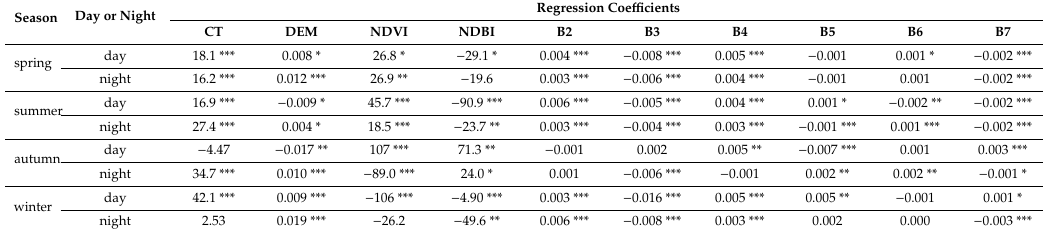
Figure 6. Scatter diagrams of predicted land surface temperature (LST) data based on the TsHARP models ( y -axis) versus Moderate Resolution Imaging Spectroradiometer (MODIS) LST data ( x -axis). (The black dashed lines represent the 1:1 line; that is, the predicated LST and MODIS LST of the scattered points falling on this line are equal). Table 3. The regression coe ffi cients of the MLR models during day and night in four seasons. Season